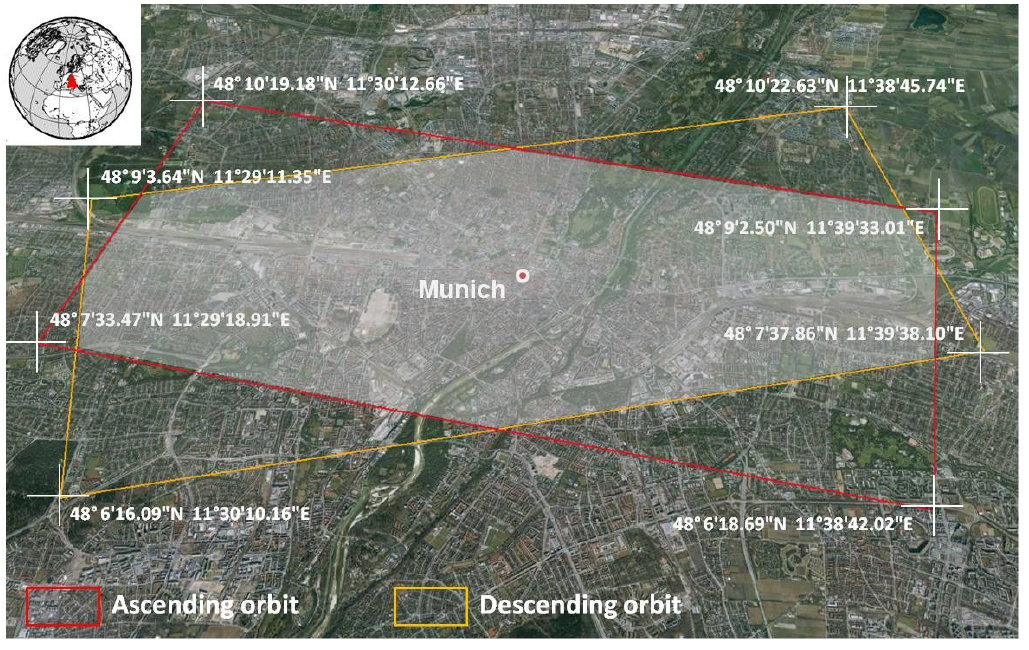
Figure 3. The image data footprints and the study area. Each footprint covers an area of approximately 10 × 5 km. Their intersection area was defined as our study area. The central point coincides with the historical center of Munich